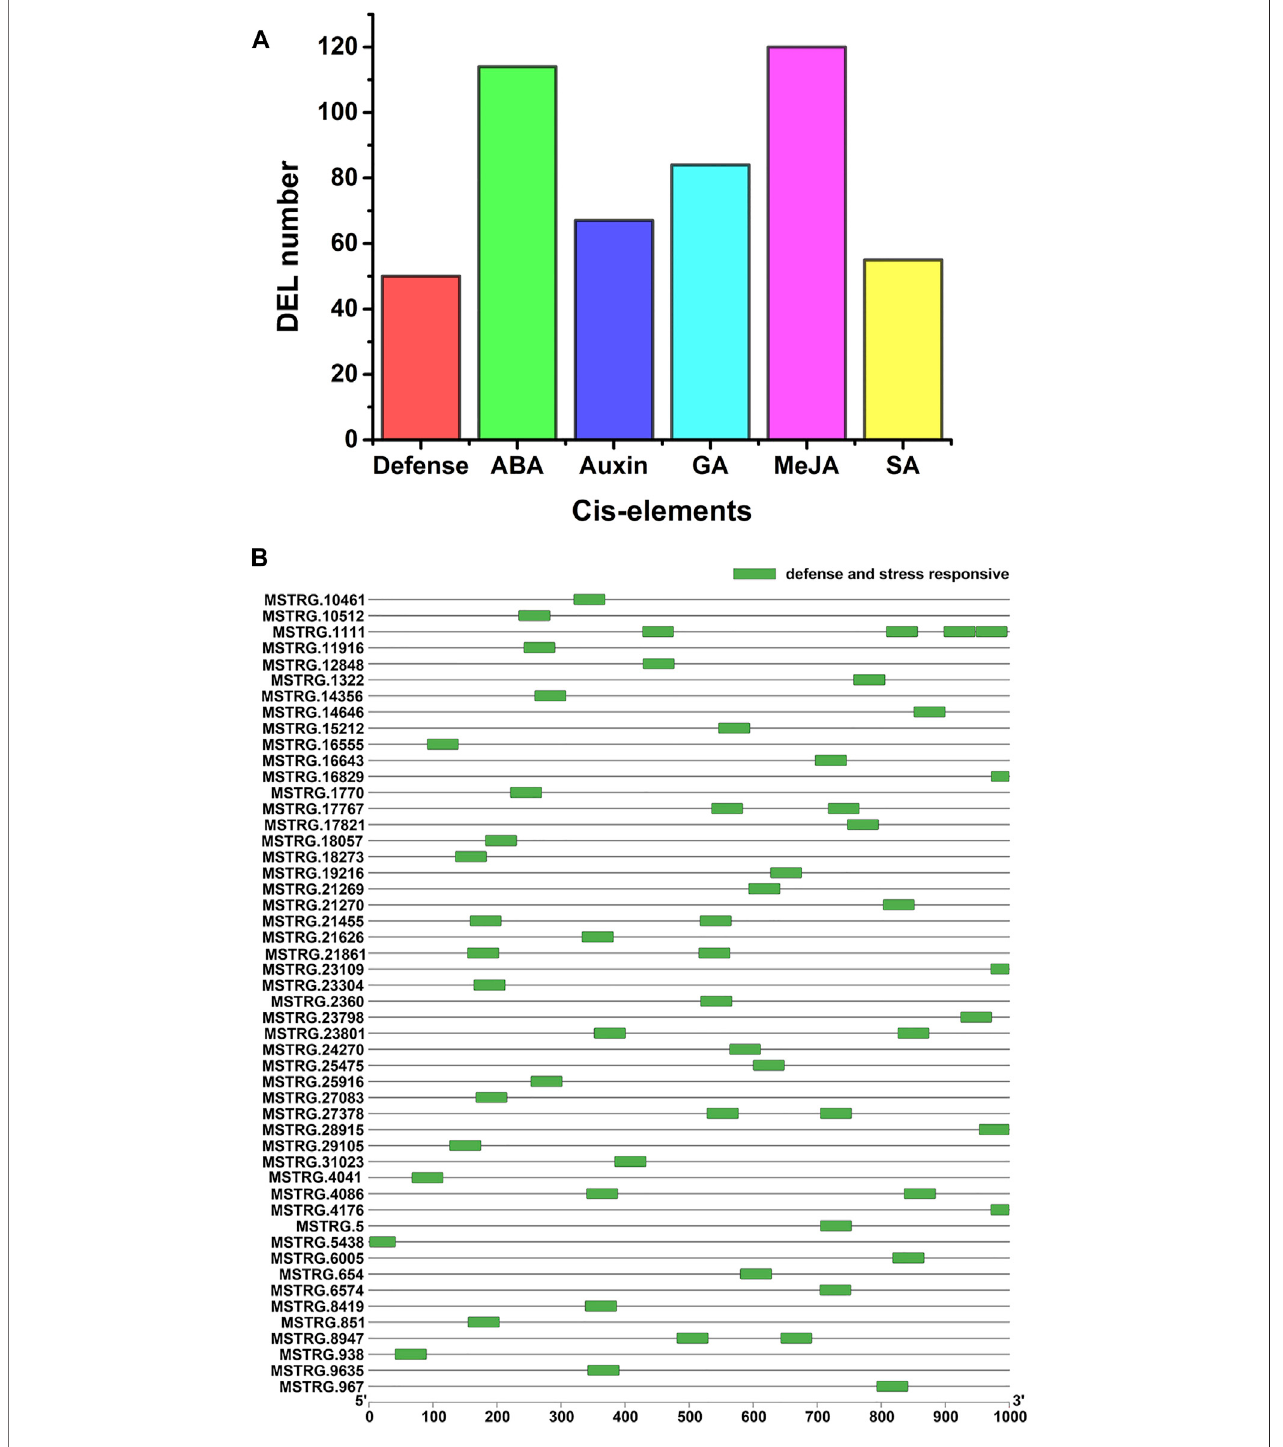
FIGURE 4 | Cis-elements in the promoters of the PM-responsive lncRNA genes. (A) Different types of cis-acting elements were identi fi ed. Defense represents defense and stress-responsive cis-element, ABA represents abscisic acid-responsive cis-element, Auxin represents auxin-responsive cis-element, GA represents gibberellinresponsivecis-element,MeJArepresentsMethylJasmonateresponsivecis-element andSArepresentssalicylicacid-responsivecis-element. (B) Distribution of cis-acting elements involved in defense and stress responses in PM-responsive lncRNAs.